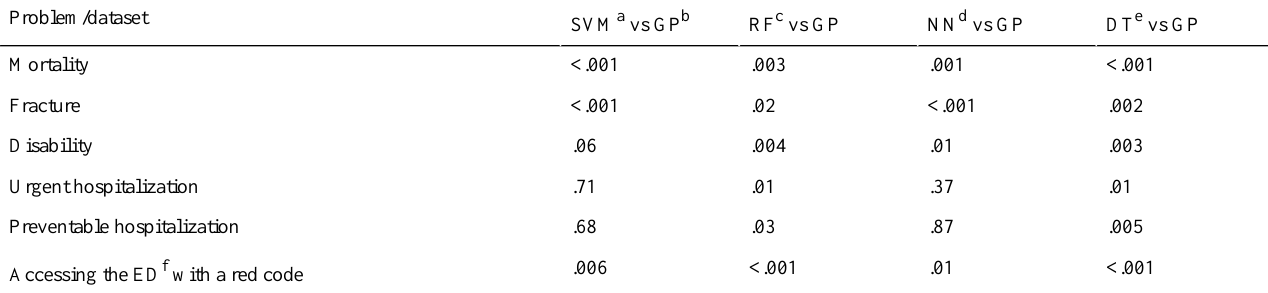
Table 4. Results of Wilcoxon signed-rank test in terms of P